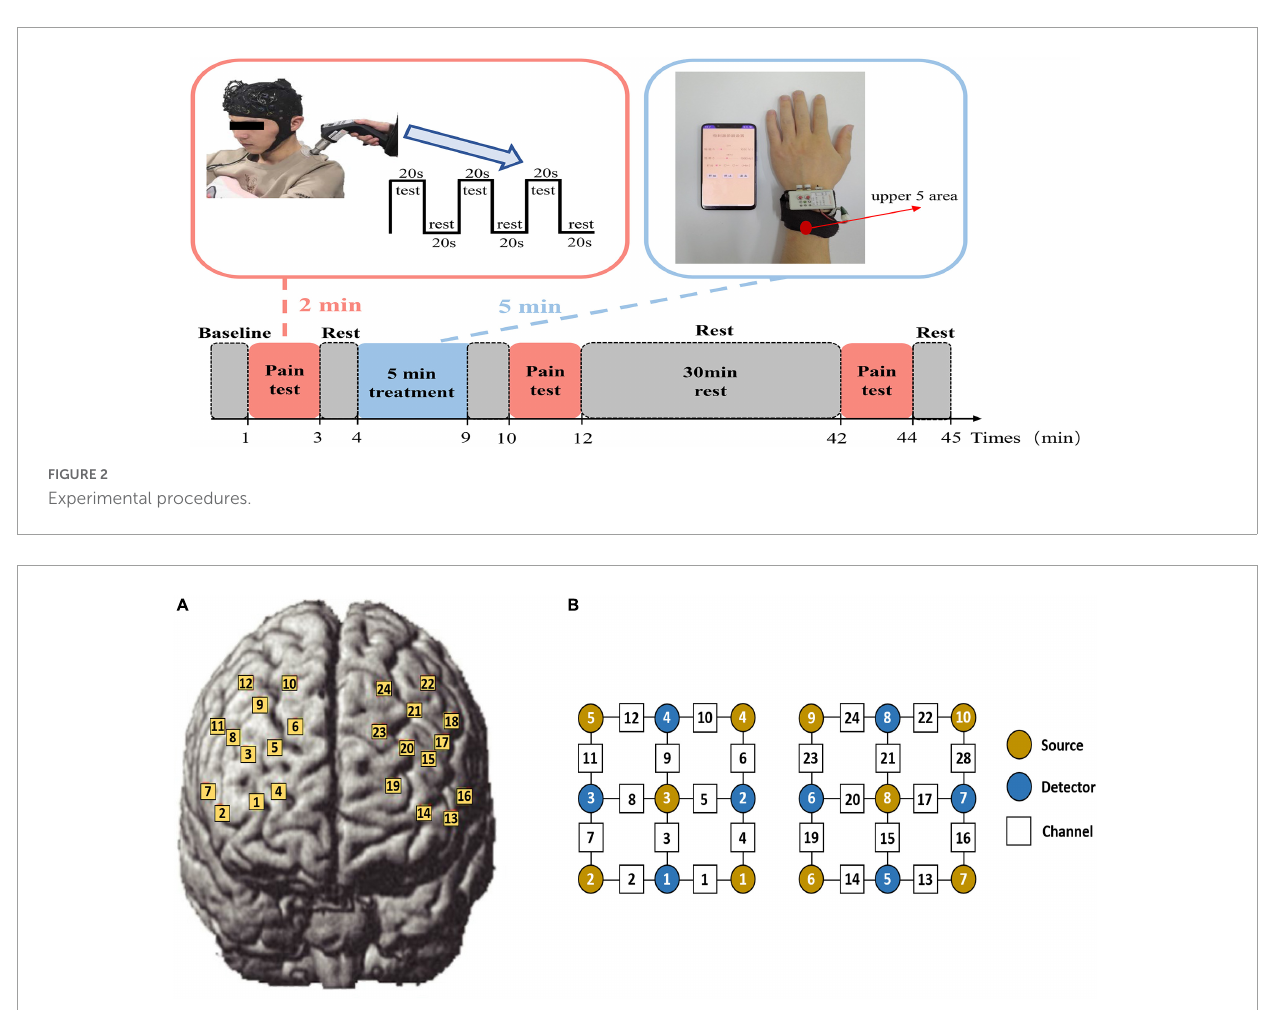
FIGURE3 Functional near-infrared spectroscopy (fNIRS) photopole arrangement template. (A) Three-dimensional diagram of the distribution of 18 photopoles and 24 channels on the scalp surface. (B) Planar diagram of the photopolar